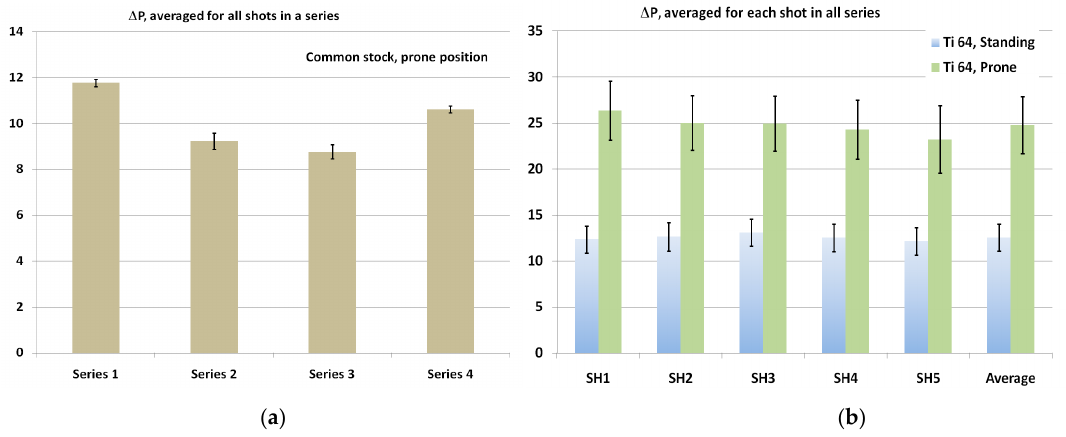
Figure 5. ( a ) Variation in the peak pressure between four different representative series, averaged for all shots in the series: prone position shooting, original commercial rifle stock. ( b ) Variation in the peak pressure between consecutive shots: shots one to five in the series (‘SH1’—’SH5’), values are averaged for all series; values averaged for all shots in all series (‘Average’); Ti alloy stock, standing and prone position